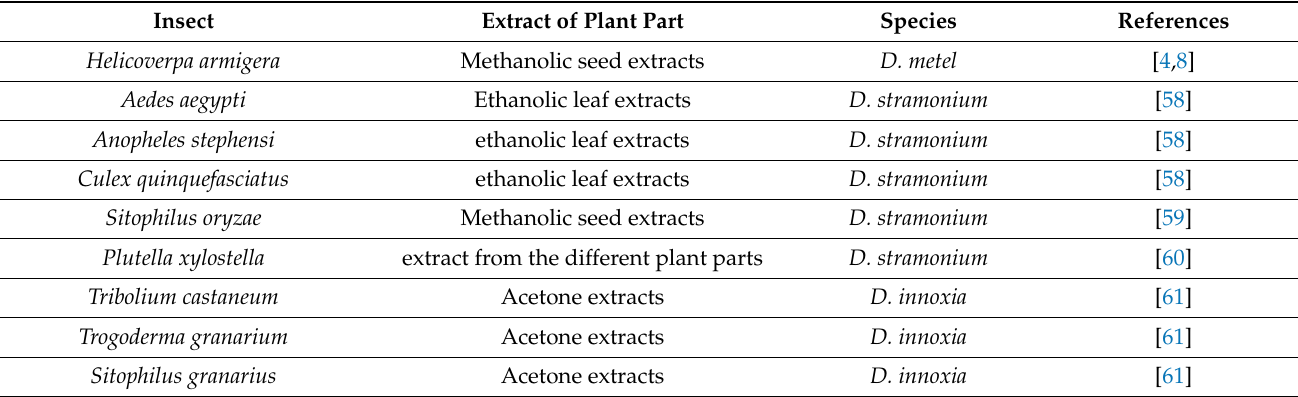
Table 4. Activity of different plant parts of Datura species against harmful